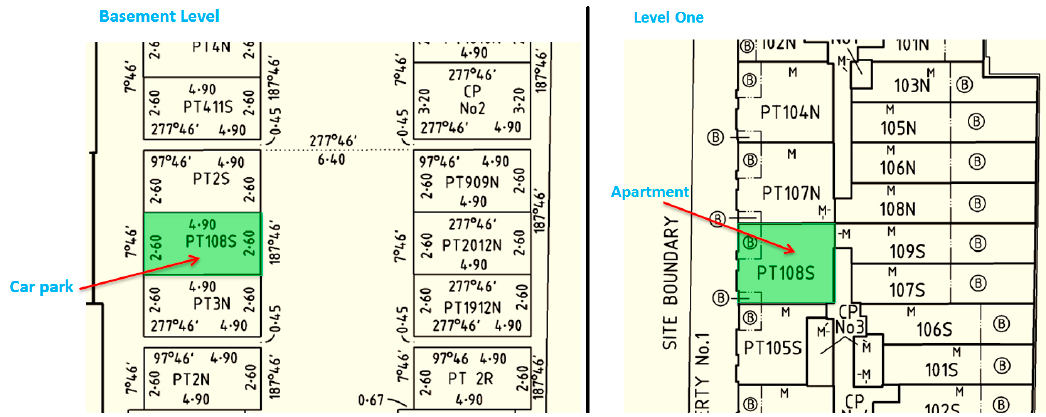
Figure 4. Parts of a volumetric lot.